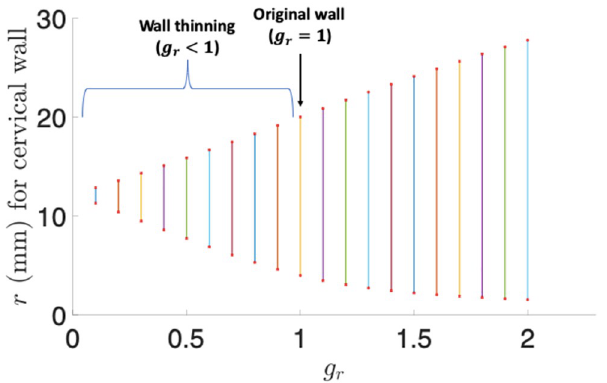
Fig 4. The cervical wall radius and thickness for the radial growth parameter g r over (0.1, 2). The lower point of each line interval shows r 1 for the inner boundary, and the upper point shows r 4 for the outer boundary. The length of each vertical line section illustrates the cervical wall thickness corresponding to a specific radial growth